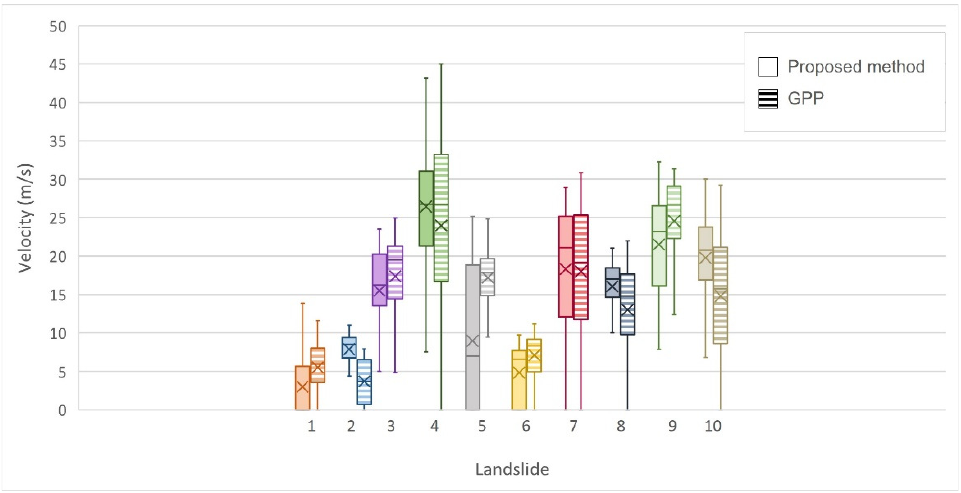
Figure 13. Boxplots of the velocity values of the selected sample of shallow landslides. The full-colour boxplots refer to the proposed method velocity values, and the dashed ones to the GPP velocity values. The colours correspond to those used in Figure 11. The boxplot consists of a box, delimited by the first and third quartiles, with the median value reported inside, and two whiskers that connect the box to the minimum and maximum value.